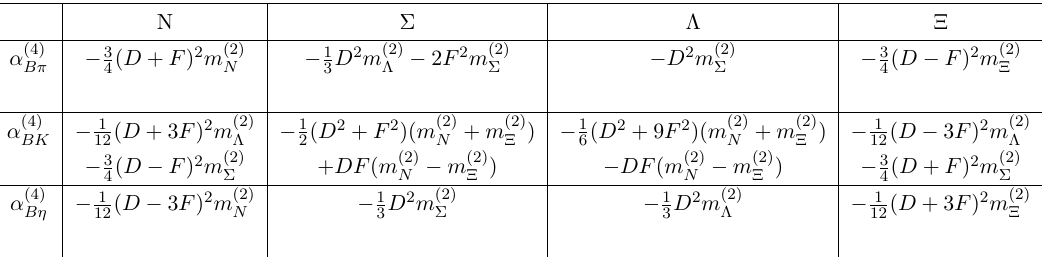
Table 4 . Coe(cid:14)cients of the O ( p 4 ) self-energy